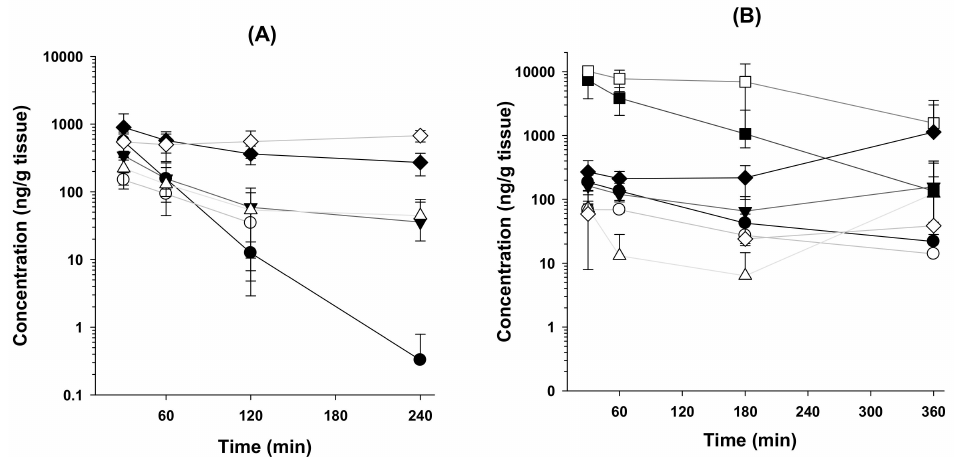
Figure 5. Mean concentration–time curves of β -amanitin in the plasma, heart, lung, liver, stomach, intestine, kidney, and spleen after ( A ) an intravenous injection (0.8 mg/kg) and ( B ) an oral admin- istration (10 mg/kg).